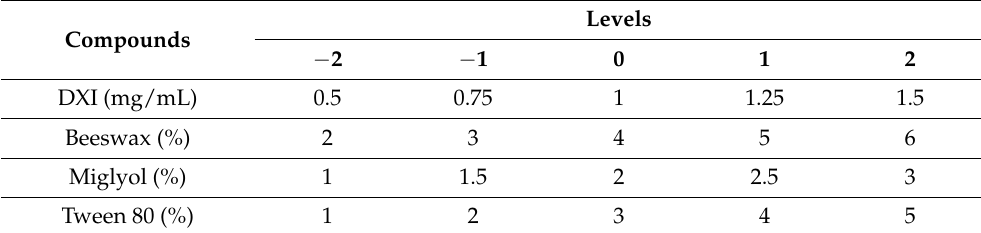
Table 8. Chemical concentrations employed for